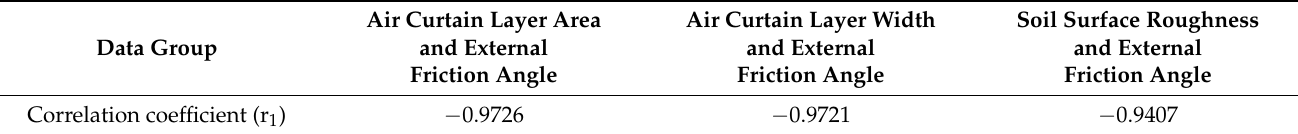
Table 4. Correlation analysis results of area and width of the air curtain layer, soil surface roughness, and external friction